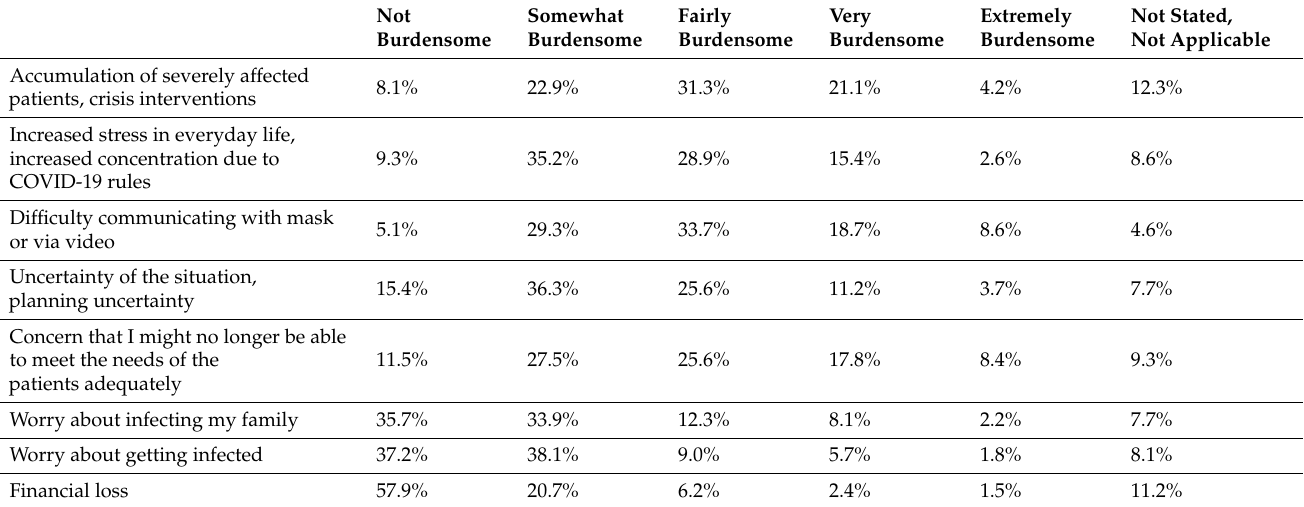
Table 5. What was or is particularly stressful/burdensome in your work under pandemic